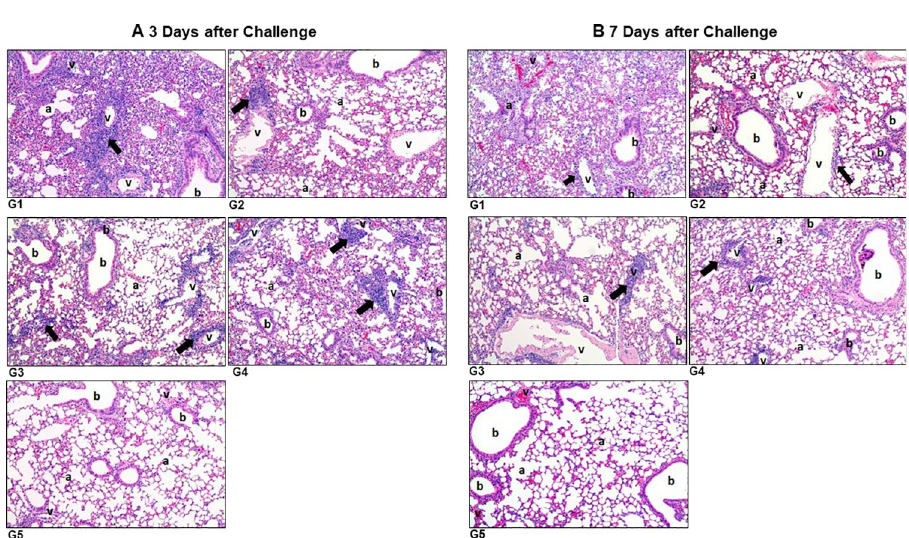
Fig 11. Histopathological findings in the lungs of hACE2 mice. Human ACE2 transgenic mice were vaccinated and challenged with SARS-CoV-2 as described in Fig 9. Left lobes of mice lungs were fixed in 10% buffered formalin on day 3 and day 7 after the SARS-CoV-2 challenge. Lung tissues were processed and embedded in low-melting paraffin, sectioned to a thickness of 3 μ m, and stained with hematoxylin and eosin. Stained tissues were examined under a light microscope (Olympus CS41, Japan) with 100X magnification. Note: a, alveolus; b, bronchiole; v, blood vessels. (A) Lung tissue 3 days after the SARS-CoV-2 challenge. (B) Lung tissue 7 days after SARS-CoV-2 challenge. Arrows show infiltration of inflammatory cells (lymphocytes and macrophages). G1: empty vector infected mice, G2: 5X10 8 of rVSV Ind -msp-S F -Gtc/ rVSV NJ -msp-S F -Gtc vaccinated mice, G3: 5X10 8 of rVSV Ind -msp-S F -Gtc/ rVSV Ind -msp-S F -Gtc vaccinated mice, G4: 5X10 7 of rVSV Ind -msp-S F -Gtc/ rVSV NJ -msp-S F -Gtc vaccinated mice, G5: uninfected